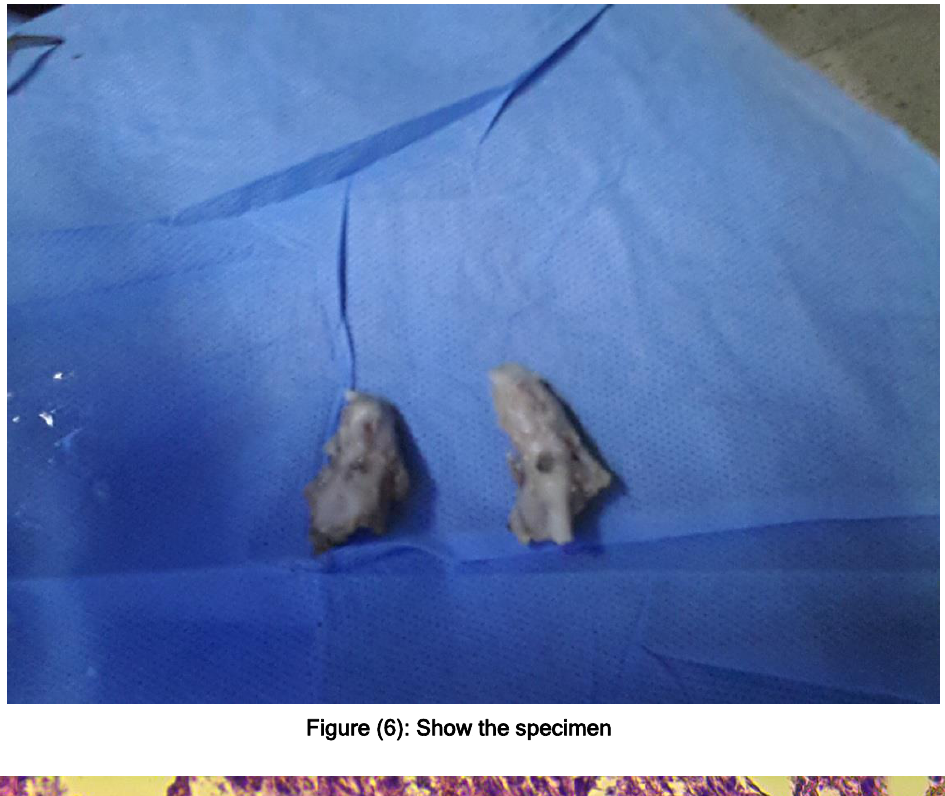
Figure (6): Show the specimen